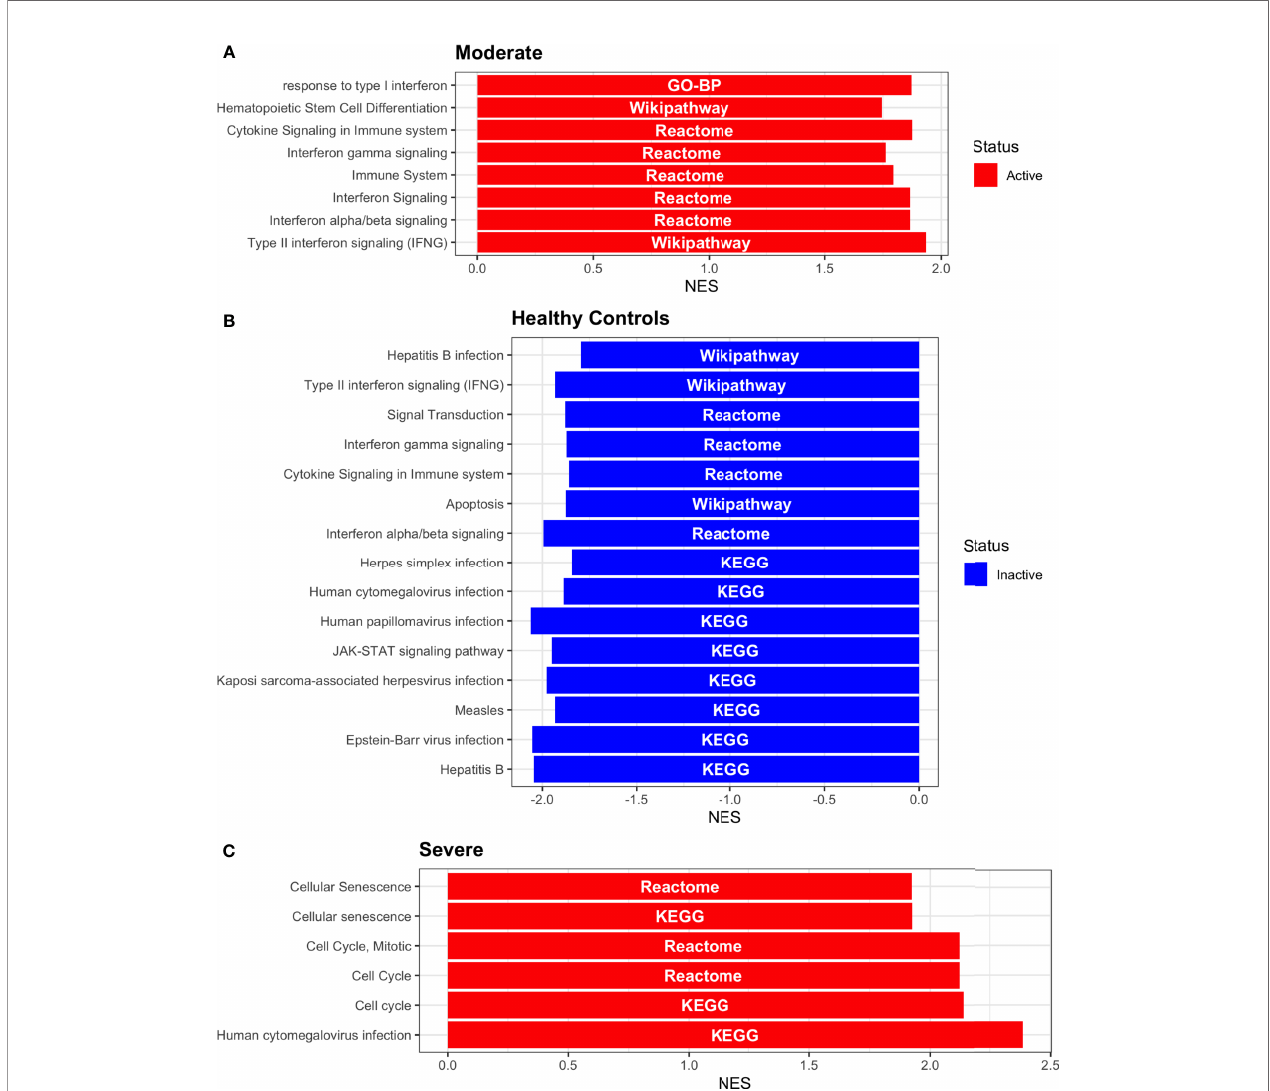
FIGURE 12 | Pathway Enrichment Analysis across various databases. Activity status of the TFs in a particular pathway found by DoROthEA across the disease severity in B-cells. (A) GSEA in moderate patients. (B) GSEA in healthy controls. (C) GSEA in severe patients. The normalized enrichment score (NES) value represents the activity status within the disease severity conditions, a positive value for active pathways (red), and a negative value for inactive pathways (blue). The dataset for every pathway (rows) is indicated inside the colored